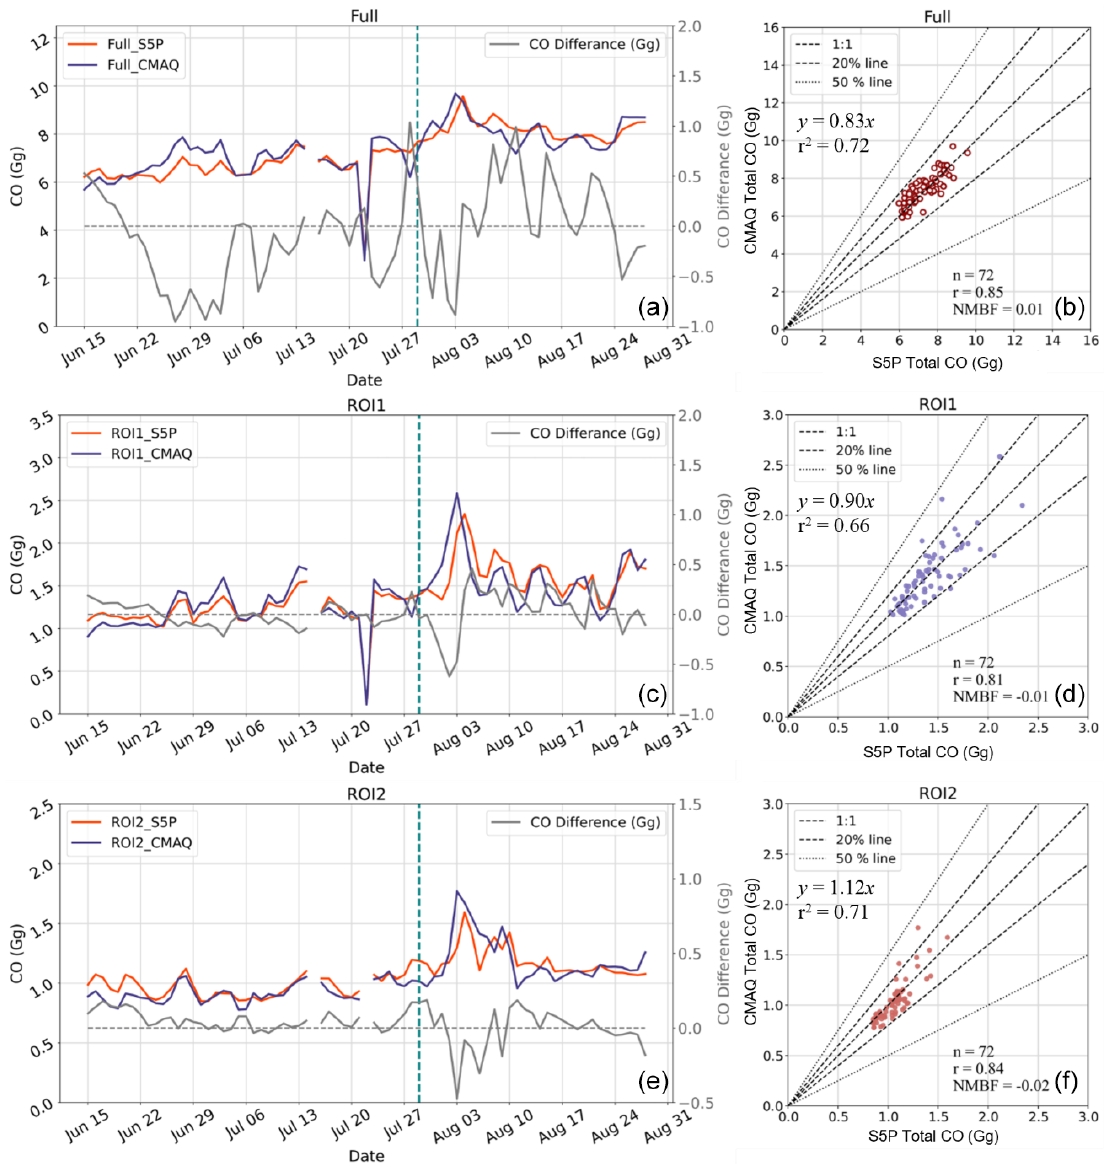
Figure 10. Results from the comparison of modelled (CMAQ) and observed (S5P) area-aggregated total CO within the full domain and two of the regions of interest (ROIs) defined in Fig. 8. (b, d, f) Time series of daily area-aggregated total CO over the full domain and the two ROIs as determined by CMAQ and S5P, with their difference represented by the solid grey line and the vertical dotted line on 29 July indicating the start of the second simulation (see main text). (a, c, e) Scatter plot comparing the daily total CO in the right-hand column plots from CMAQ and S5P. Pearson’s correlation and NMBF of the dataset are shown, along with dotted lines indicating the 1 : 1, ± 20% and ± 50% relationships. The NMBF of 0.04 indicates a mean 4% overestimation by the model compared to the observations. Results from the comparisons plotted here are summarised in Table